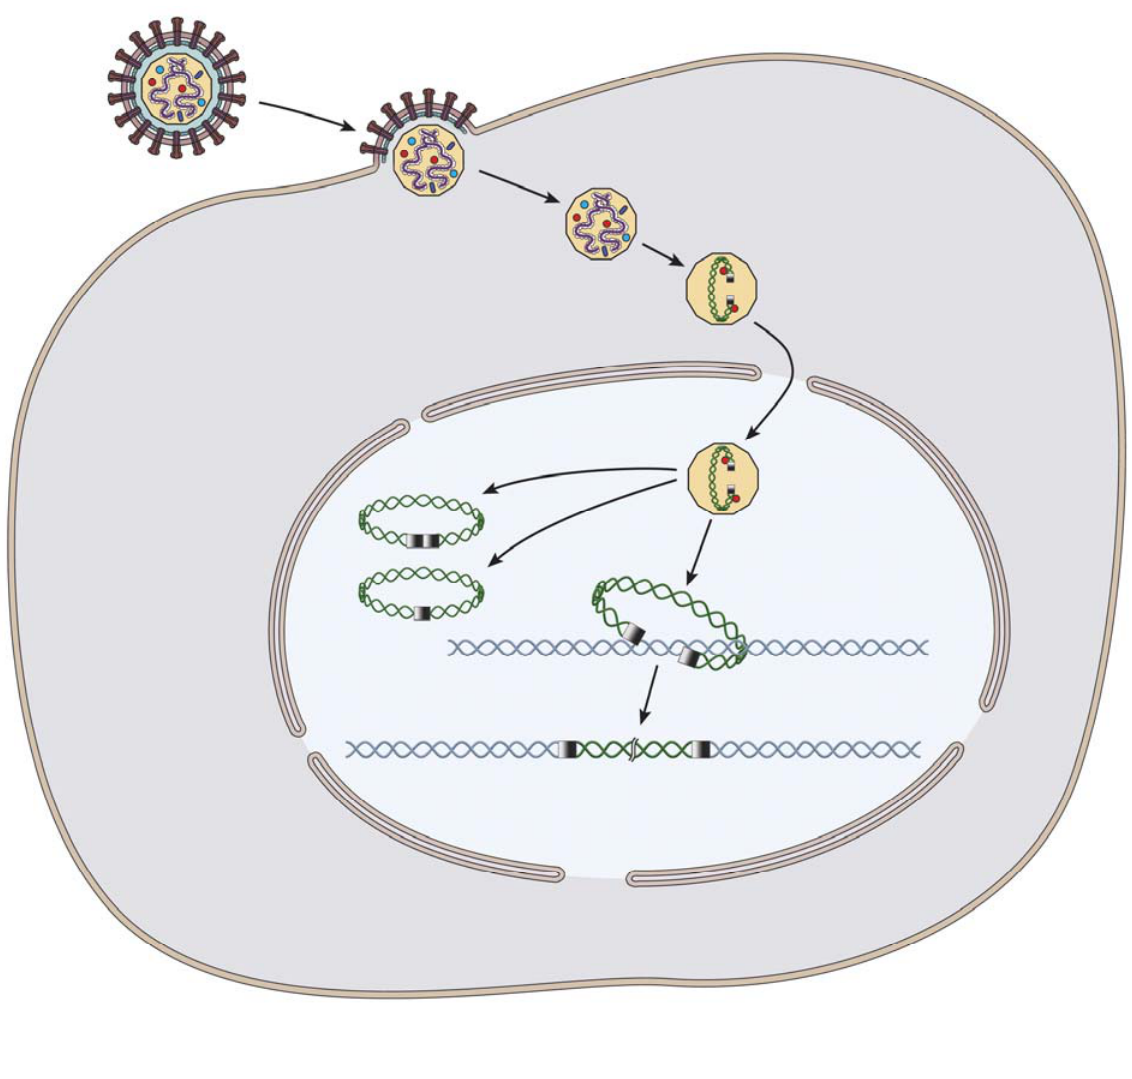
Figure 1. Early events in MLV infection leading to the production of the integrated provirus. Virions deliver a viral core particle into the cytoplasm, which carries out the process of reverse transcription to form the Pre-Integration Complex or PIC, containing the Integrase enzyme (red) bound to the termini of the Long Terminal Repeats or LTRs (grey boxes) of the viral DNA (green helix). The PIC enters the nucleus, likely via the dispersion of the nuclear membrane during mitosis. The incoming DNA is then integrated into the host genome (blue helix). DNAs that fail to integrate are often circularized by host repair enzymes to form circular DNAs with one or two copies of the viral